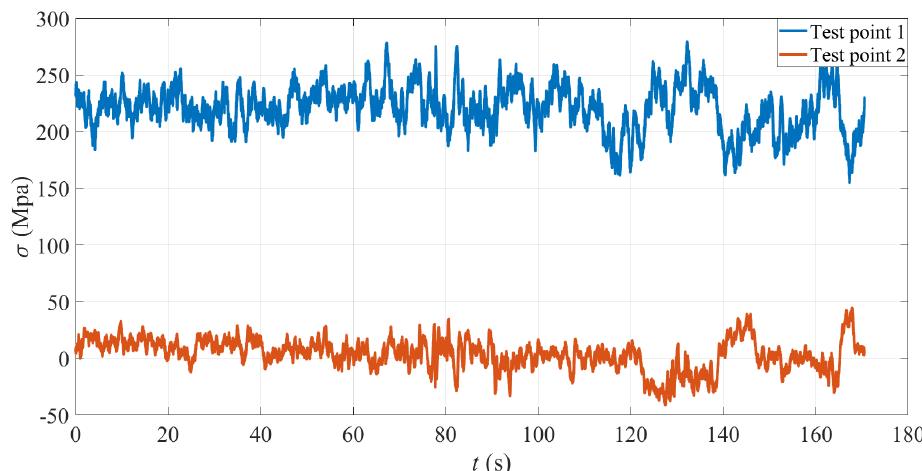
Figure 15. Amplitude spectra of the maximum principal stress on test points 1 and 2. Figure 14 shows the stresses varying with time, so it is not convenient to compare them with the simulation. Accordingly, the statistics for these stresses can be obtained, as shown in Table 3. Table 3. The statistics of the maximum principal stress on test points 1 and 2. Maximum